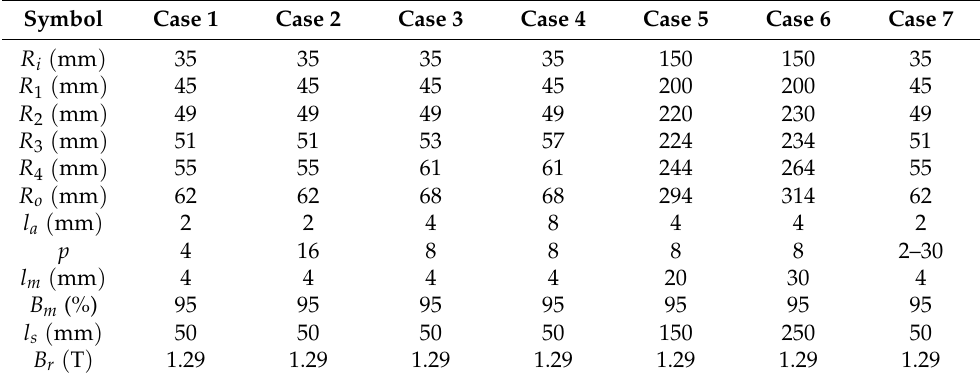
Table 2. Parameters of the CMC considered during the sensitivity